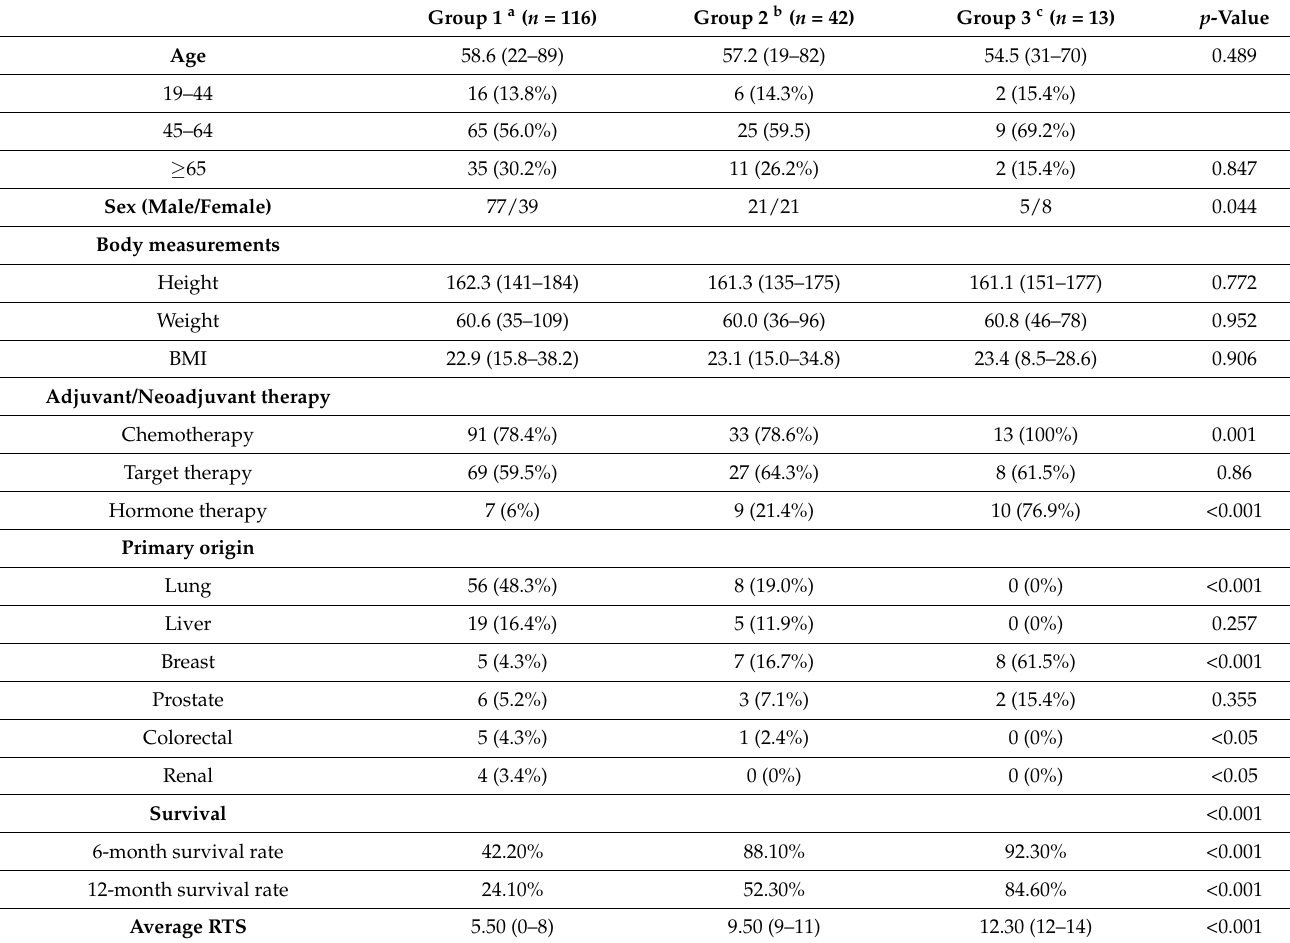
Table 1. Demographic and clinical characteristics of reference group.